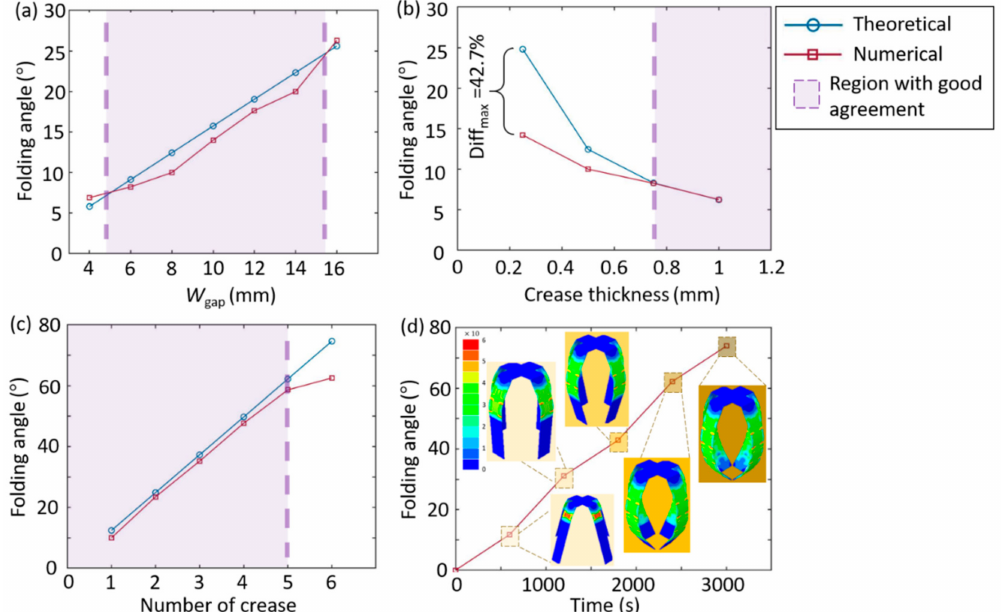
Figure 6. The crease angle variations of the microgrippers with respect to the ( a ) crease width; ( b ) crease thickness and ( c ) number of creases. ( d ) Variation of the entire folding angle with heating time for the microgrippers.